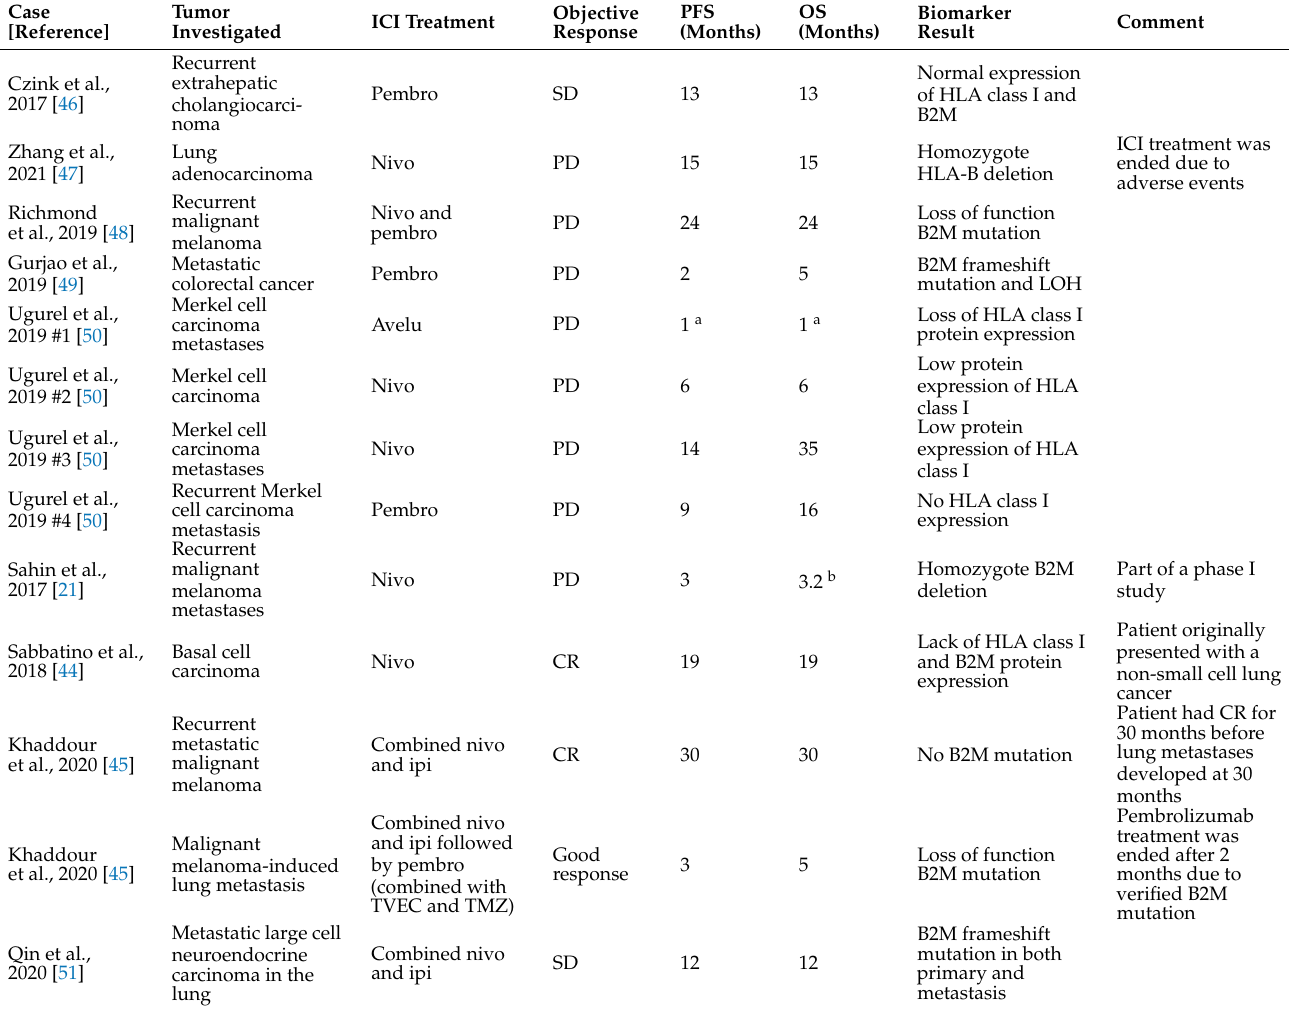
Table 2. Clinical response to ICI therapy in relation to defects in the APM (case